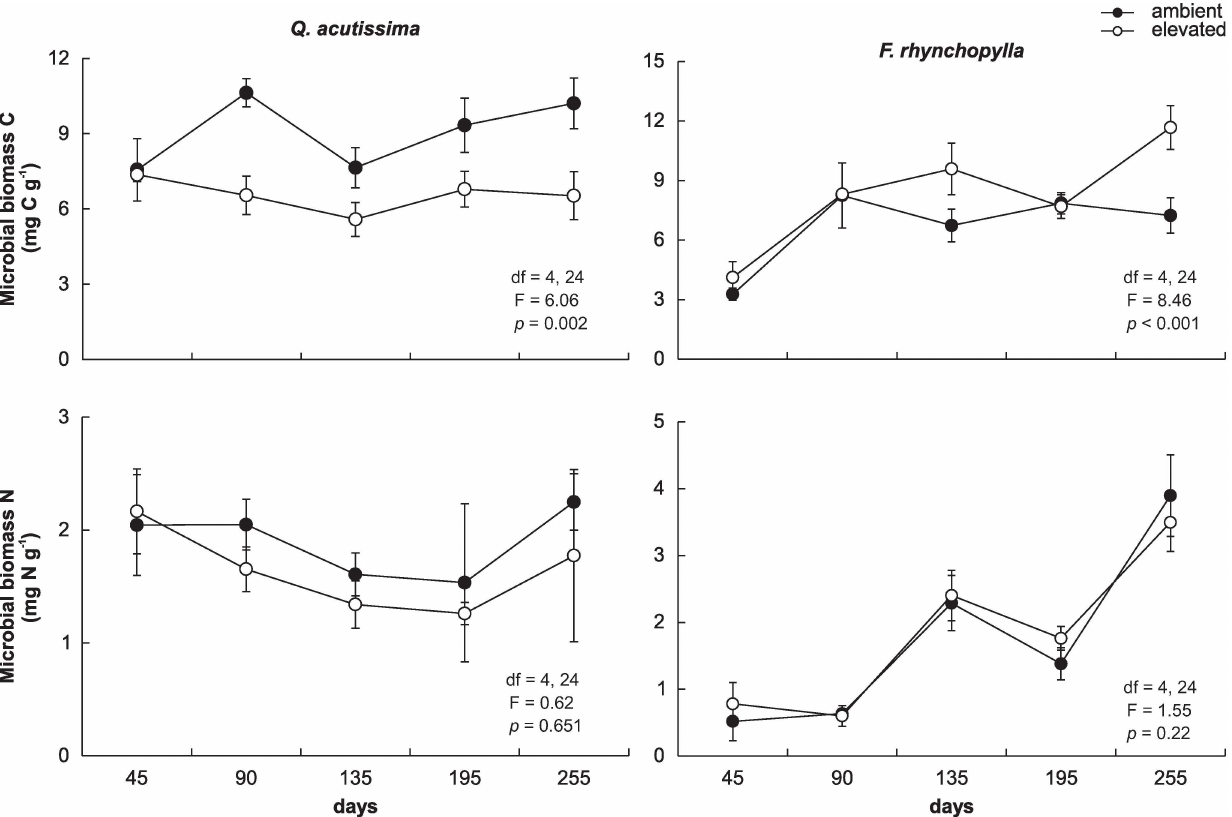
Fig 2. Changes in the microbial biomass C and N of the decomposing leaf litter in the microcosms. Closedcircles show leaf litter obtainedfrom the ambientair (380 ppm CO 2 ) chamber, and open circles representleaf litter obtainedfrom the elevated CO 2 (700 ppm) chamber. Bars show standard deviations (n =